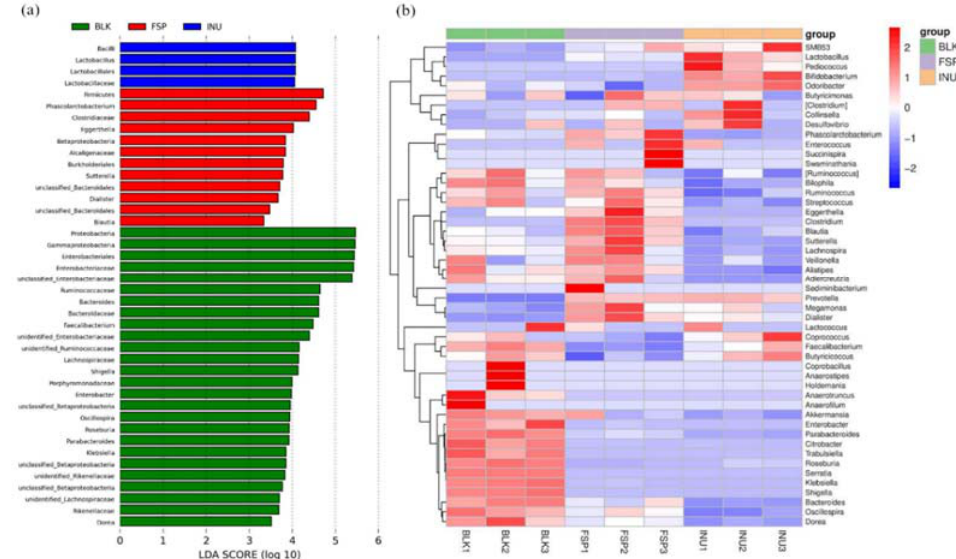
Figure 5. Comparisons of intra-group variance at OTUs level using LefSe. ( a ) LDA scores computed for features at OTUs level; ( b ) heatmap of the relative abundance of OTU (log 10 transformed).